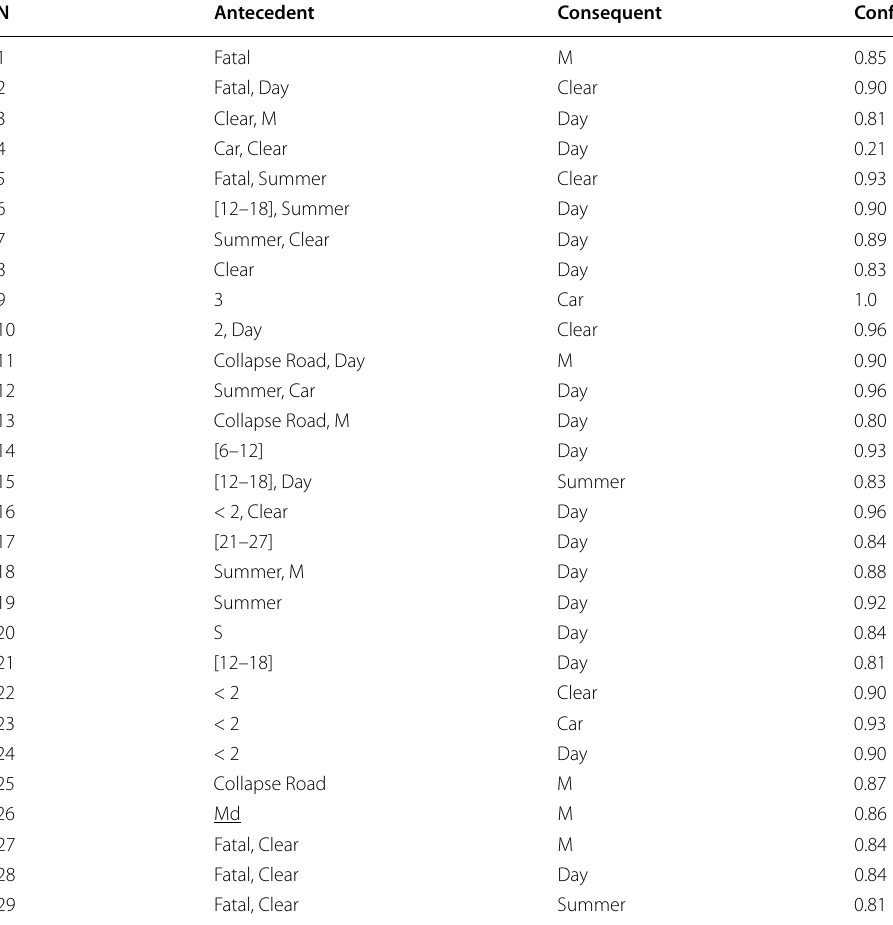
Table 6 The extracted association